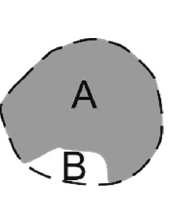
Figure 2. Scheme of a particle: the gray area (A) and hull-dotted line (A + B) [27]. Solidity is the grain area (A) divided by the area enclosed by the convex hull (A + B) The grains with the Solidity value of 1 are characterised by smoothness, while the values of 0 are particles with irregular and rough edges. Solidity is calculated as (Formula (3)) [27]: Solidity = ( Area of A ) / ( Area of A + B ) Aspect Ratio is the ratio of the width to length of the particle. Aspect Ratio values range from 0 to 1. For example, the Aspect Ratio of a circle has a value of 1. Aspect Ratio is calculated as (Formula (4))